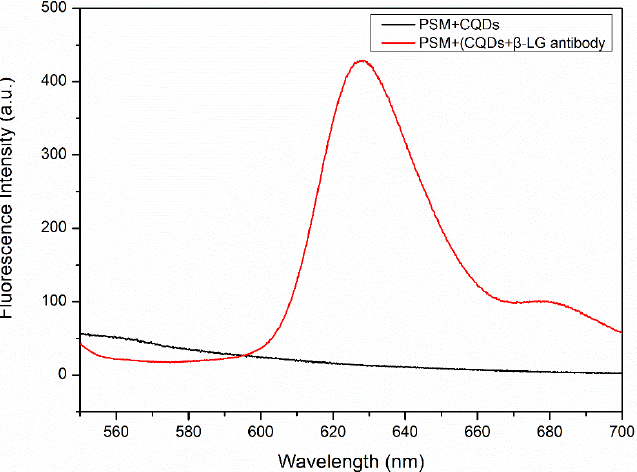
Figure 8. The red curve represents the fluorescence spectra of 100 µ g/L CQDS-linked β -LG antibody after addition to a functionalized PSM device, and the black curve represents the fluorescence spectra of QDs after addition to a functionalized PSM device.